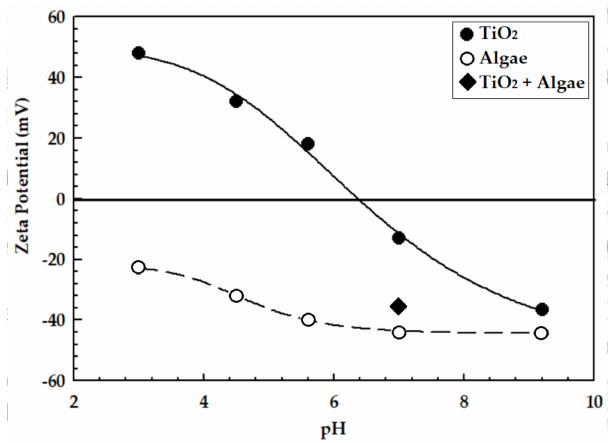
Figure 2. Zeta potential values of algae and TiO 2 NPs as a function of